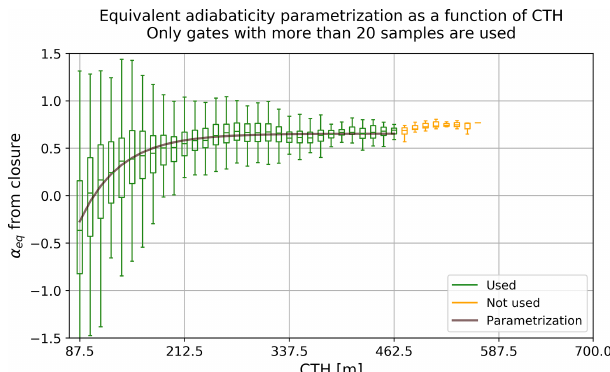
Figure 4. Boxplot with the distribution of equivalent adiabaticity for each radar CTH bin, with the derived parametrization superim- posed (Eq. 7). Equivalent adiabaticity is calculated by closure using Eq. (6). Only samples with visibility below 2000m are